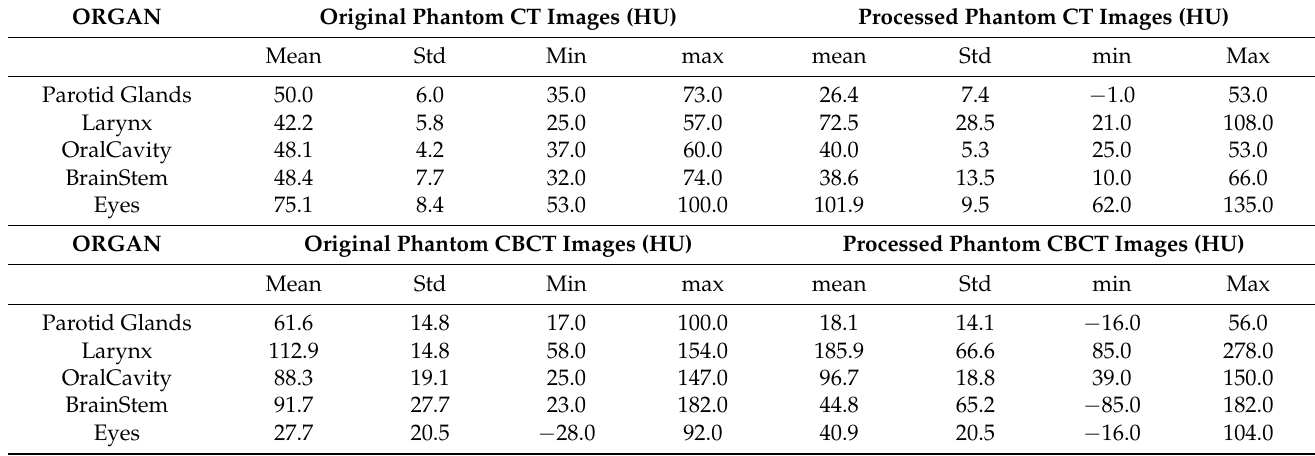
Table 1. Original and post-processed CT and CBCT transverse sections of the CIRS ATOM Max Dental and Diagnostic Head Phantom Model-711 used in the method presented for QA of DIR. The HU values of parotid glands, larynx, oral cavity, brainstem and eyes were digitally modified using MATLAB and CERR tools, as described in Section 2.1. HU values for original and post-processed CT and CBCT phantom images reported in the table referred to a ROI of 20 × 20